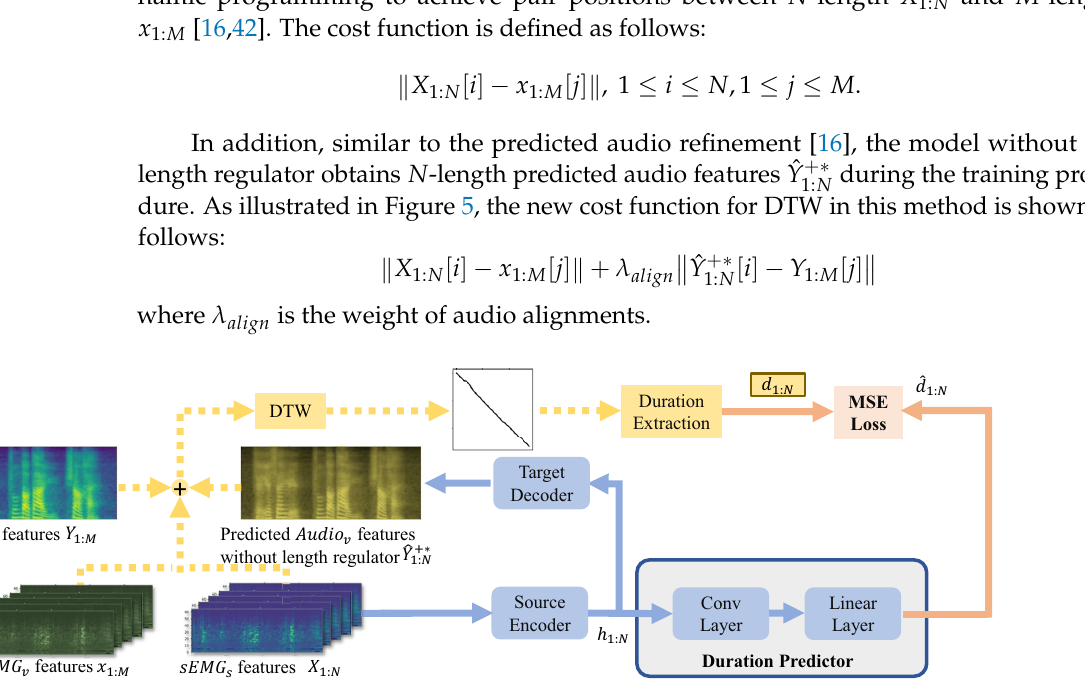
Figure 5. Illustration of duration extraction and predictor. The gray block represents the duration